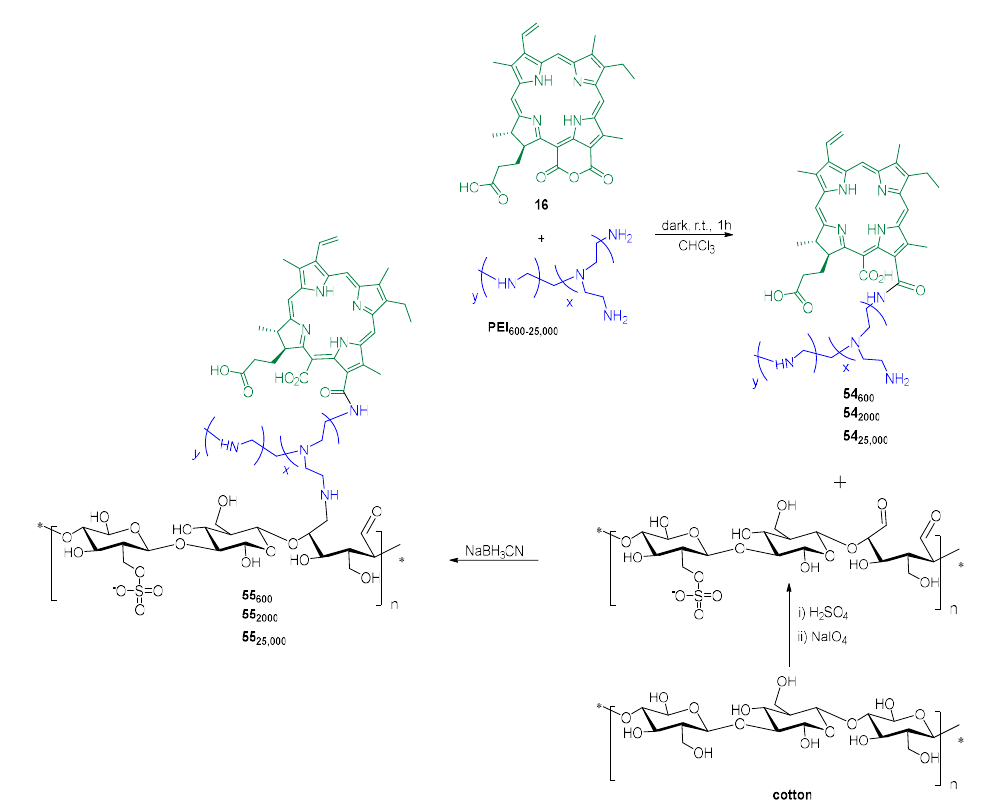
Figure 36. Synthetic methodology adopted by Sol and co-workers to fabricate new cellulose nanocrystals materials ( 55 600-25,000 ), bearing purpurin 18 ( 16 ), conjugated with polyethyleneimine scaffolds (adapted from Ref. [68] ).